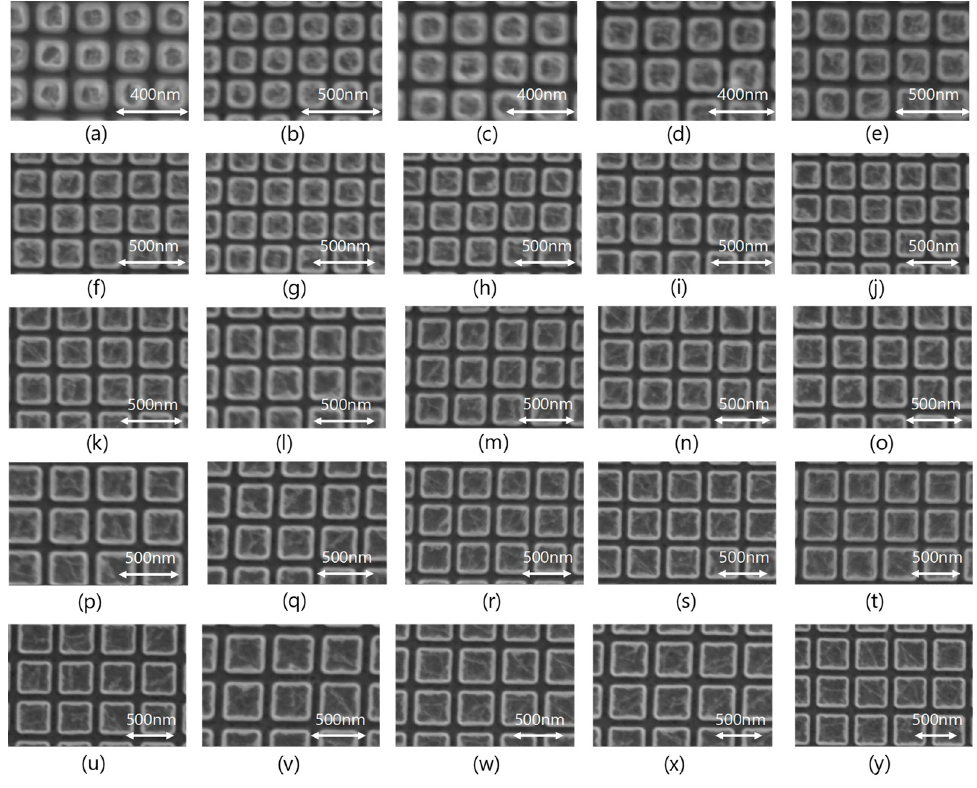
Figure 9. SEM images of fabricated color filters. ( a ) Λ = 220 nm, ( b ) Λ = 230 nm, ( c ) Λ = 240 nm, ( d ) Λ = 250 nm, ( e ) Λ = 260 nm, ( f ) Λ = 270 nm, ( g ) Λ = 280 nm, ( h ) Λ = 290 nm, ( i ) Λ = 300 nm, ( j ) Λ = 310 nm, ( k ) Λ = 320 nm, ( l ) Λ = 330 nm, ( m ) Λ = 340 nm, ( n ) Λ = 350 nm, ( o ) Λ = 360 nm, ( p ) Λ = 370 nm, ( q ) Λ =